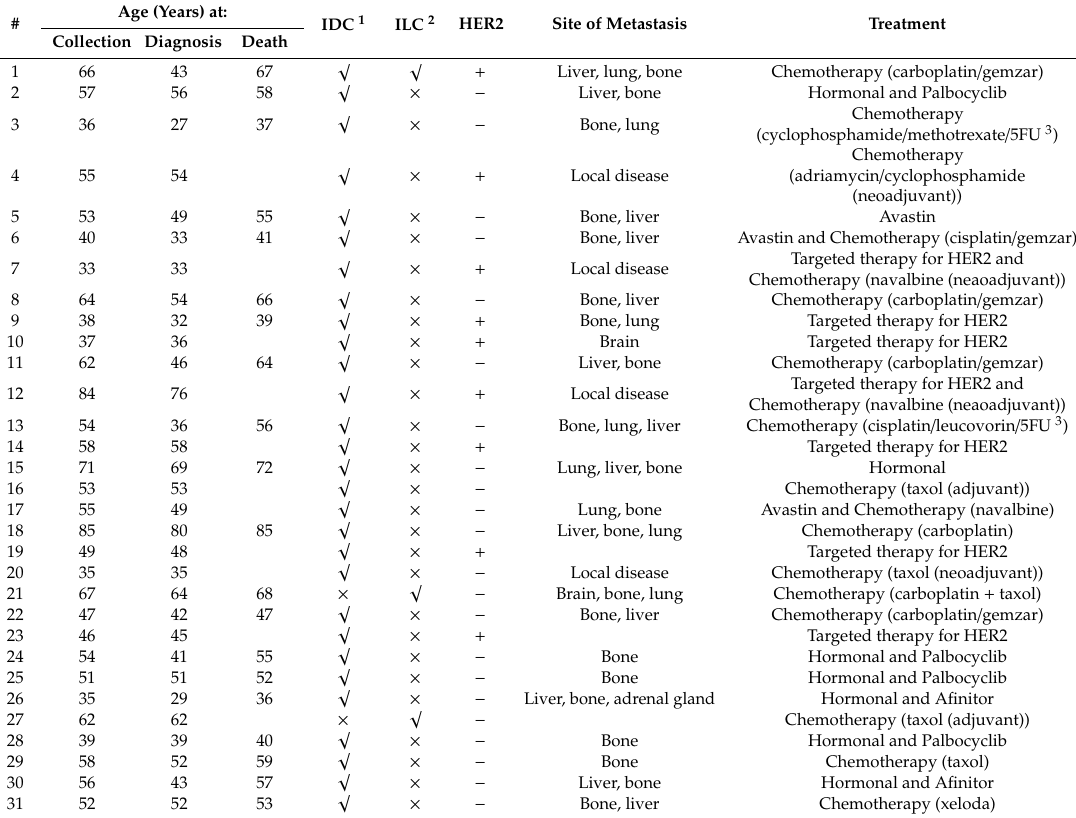
Table 1. Details of patients’ characteristics (including disease and